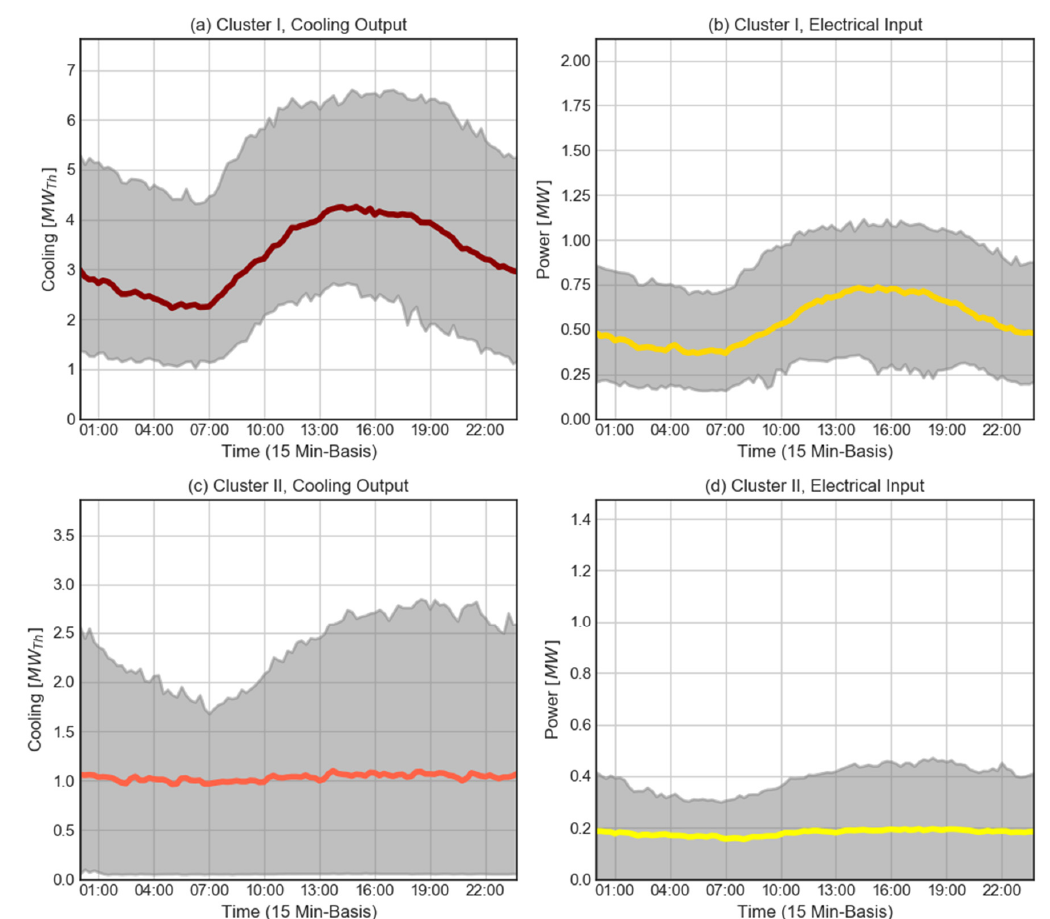
Figure 9. Typical cooling output and electrical input profiles for the chilled water system, ( a ) Operative cluster I, Cooling Output, ( b ) Operative Cluster I, Electrical Input, ( c ) Operative Cluster II, Cooling Output, ( d ) Operative Cluster II, Electrical Input.